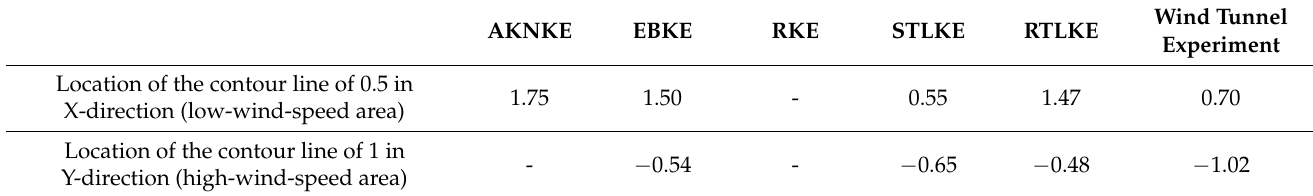
Figure 16. Contour plots of turbulent kinetic energy at z/b = 0.125. Table 13. Location of contour line at z/b = 0.125 (turbulent kinetic energy).